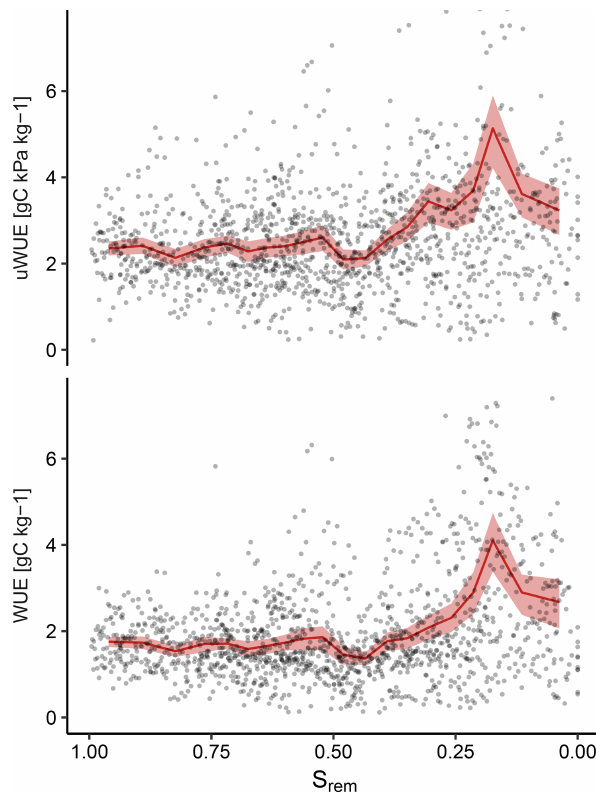
Figure 5. Response of the water-use efficiency (WUE) and the un- derlying water-use efficiency (uWUE) to the remaining soil wa- ter ( S rem ). The points represent daily observations pooled from all sites, while the red lines with the shaded area denote the mean re- sponse and its bootstrapped 95% confidence interval.